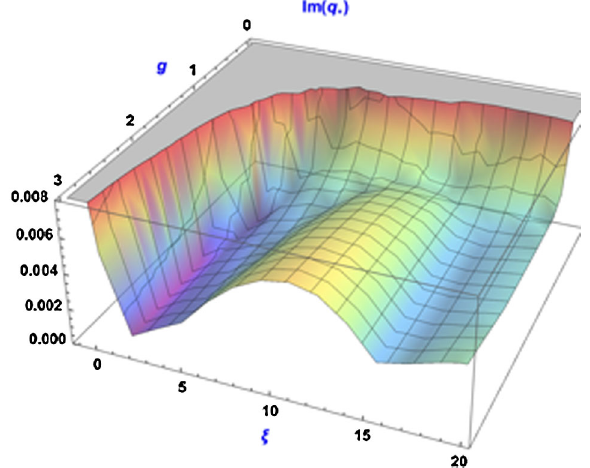
FIG. 28. The same damper phase and bunch intensity for the full 25 ns beam.